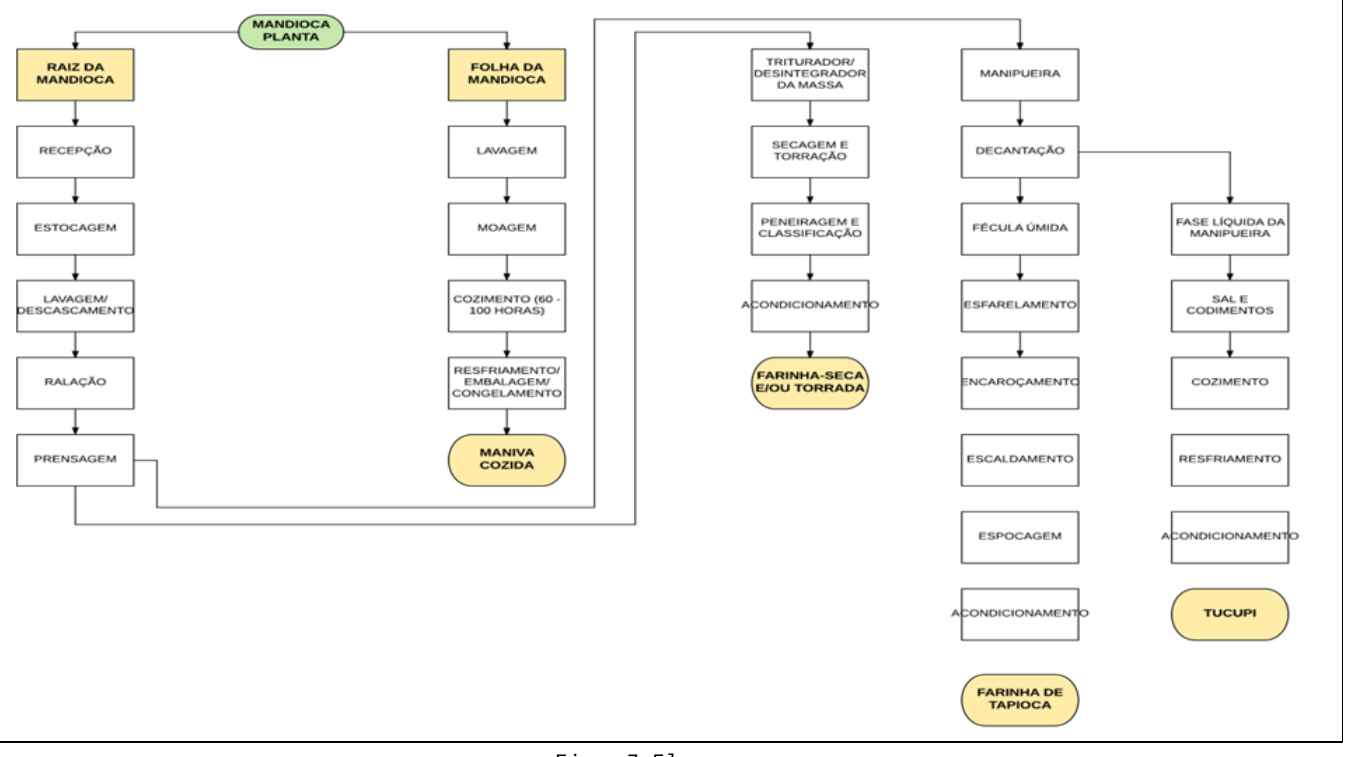
Figura 7: Fluxograma. Fonte: Autores,